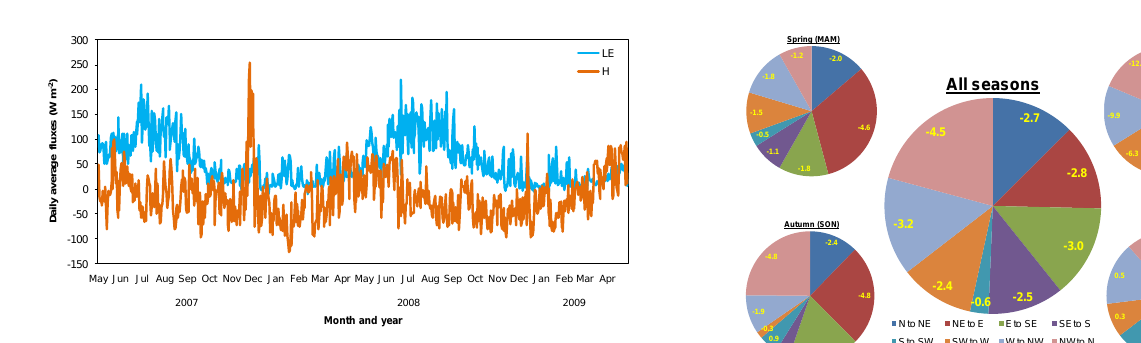
Fig. A1. Estimates of flux tower footprint. Colours in the graduated contribution to flux measurements (a, top left) represent atmospheric stability, whereby red = very unstable (ZL = − 0.5m), orange = moderate (ZL = − 0.1m) and yellow = very stable conditions (ZL = − 0.001m). ZL = flux measurement height/Monin-Obukhov length (based on Schmid and Oke, 1990). Flux tower shown as cross and woodland type types as shown in Fig. 1.